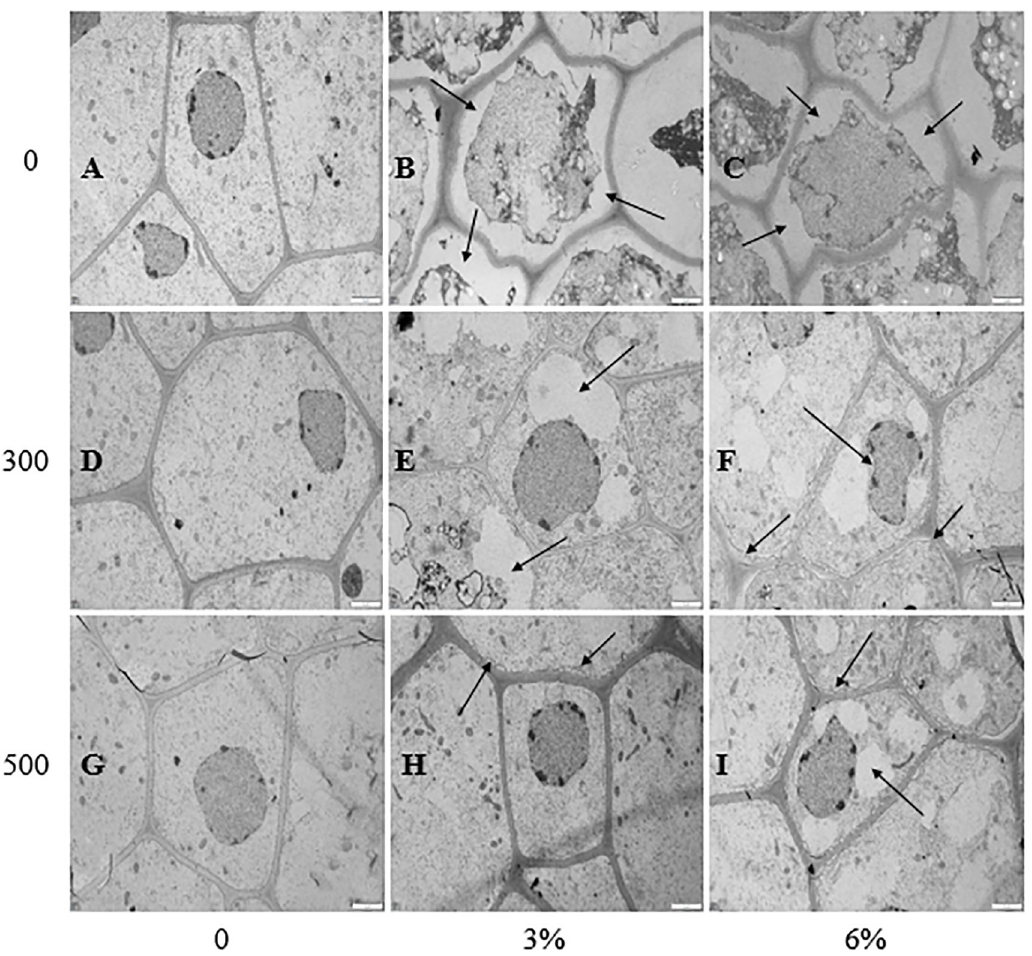
Fig 5. Transmission electron micrographs of ultrathin sections of cells from root tips treated with different treatments. The horizontal axis is PEG concentration, the vertical axis is melatonin concentration, the scale length is 2 μ m, 2000 times magnified.